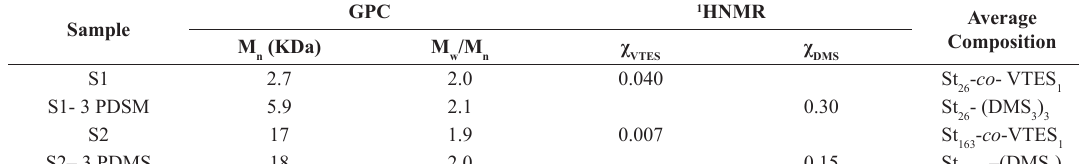
Table 1. GPC and 1 H NMR results for the macrosilane precursors, and PS end-capped 3-short-arm PDMS. Sample